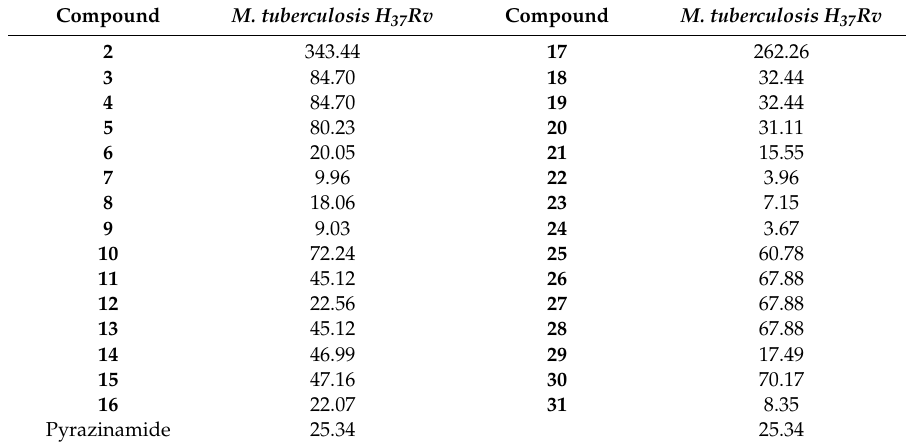
Table 2. Antitubercular activity (MIC in µ M) of chalcones ( 2 – 16 ) and dihydropyrazoles ( 17 – 31 ).